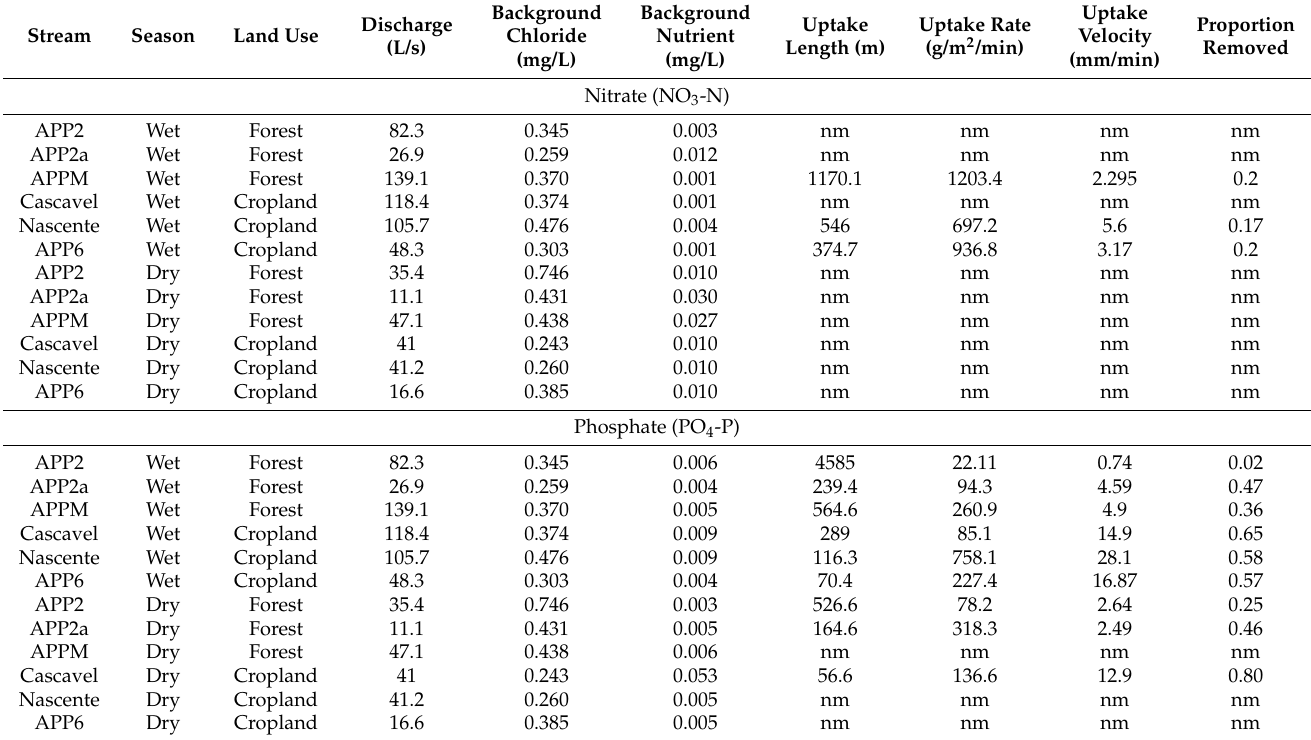
Table 3. Stream discharge, background nutrient concentrations, and nutrient uptake metrics for all streams in all seasons. Background concentrations reflect the mean of three samples collected prior to nutrient additions. “nm” = not